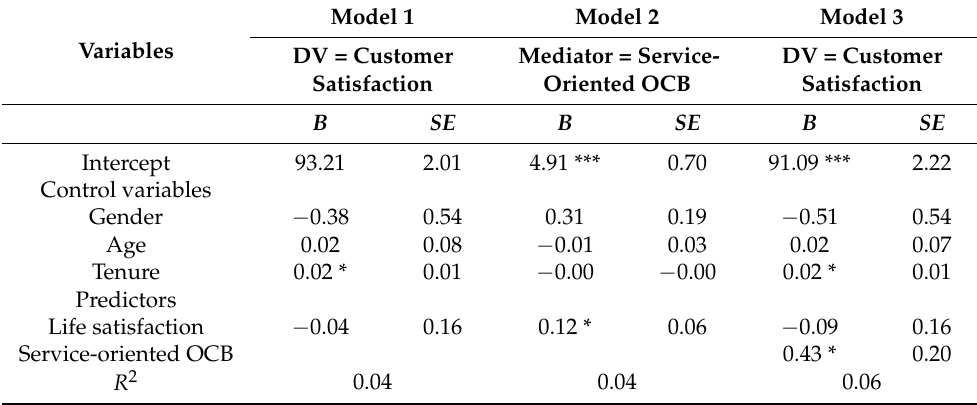
Table 3. Individual Analyses Results for Testing Hypotheses 1 to